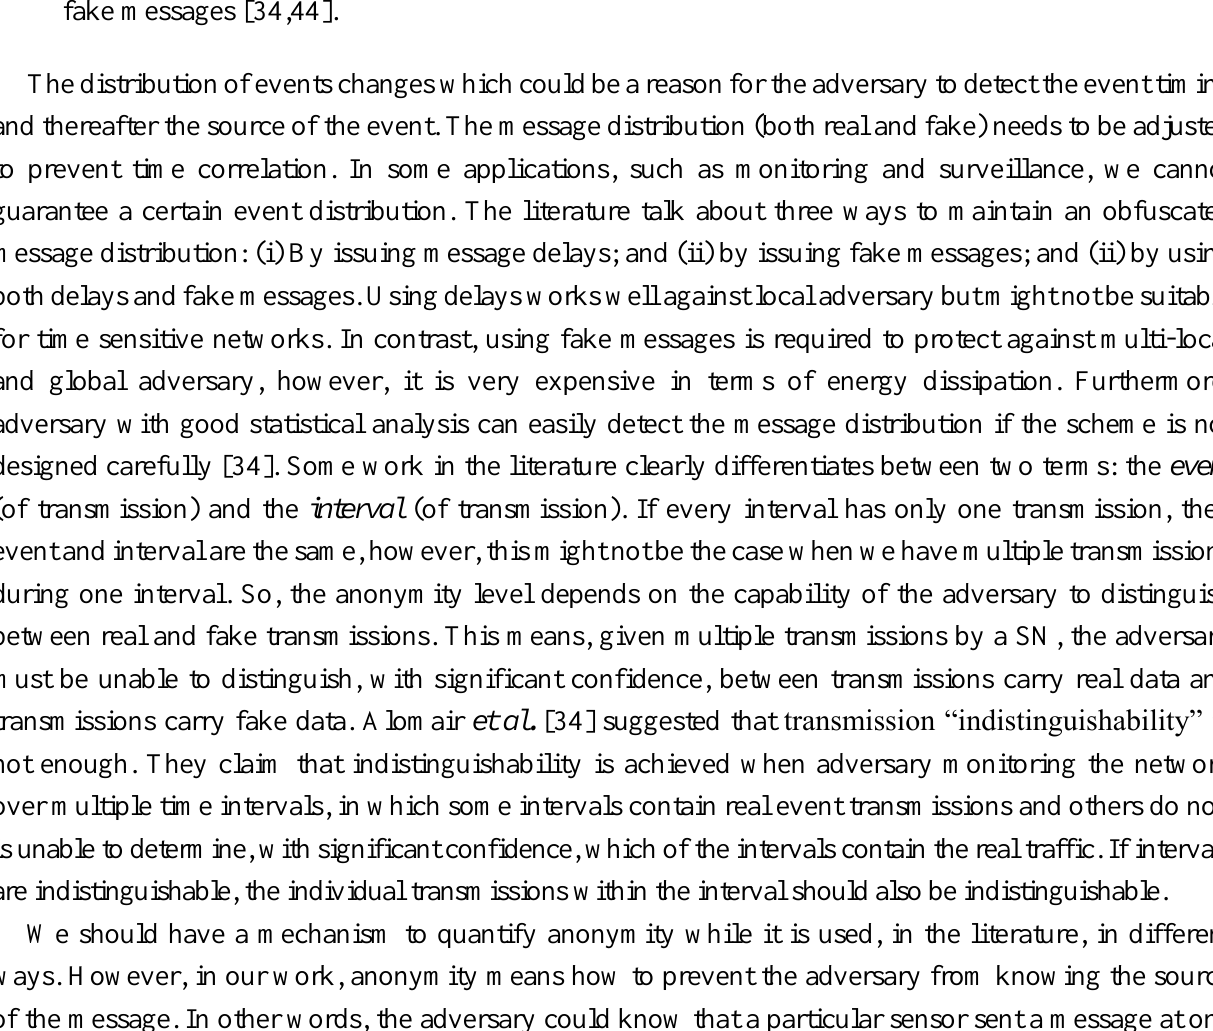
Figure 8. Nodes transmit fake messages according to a probabilistic distribution. When real messages are sent, the system should maintain the required distribution by delaying some fake messages